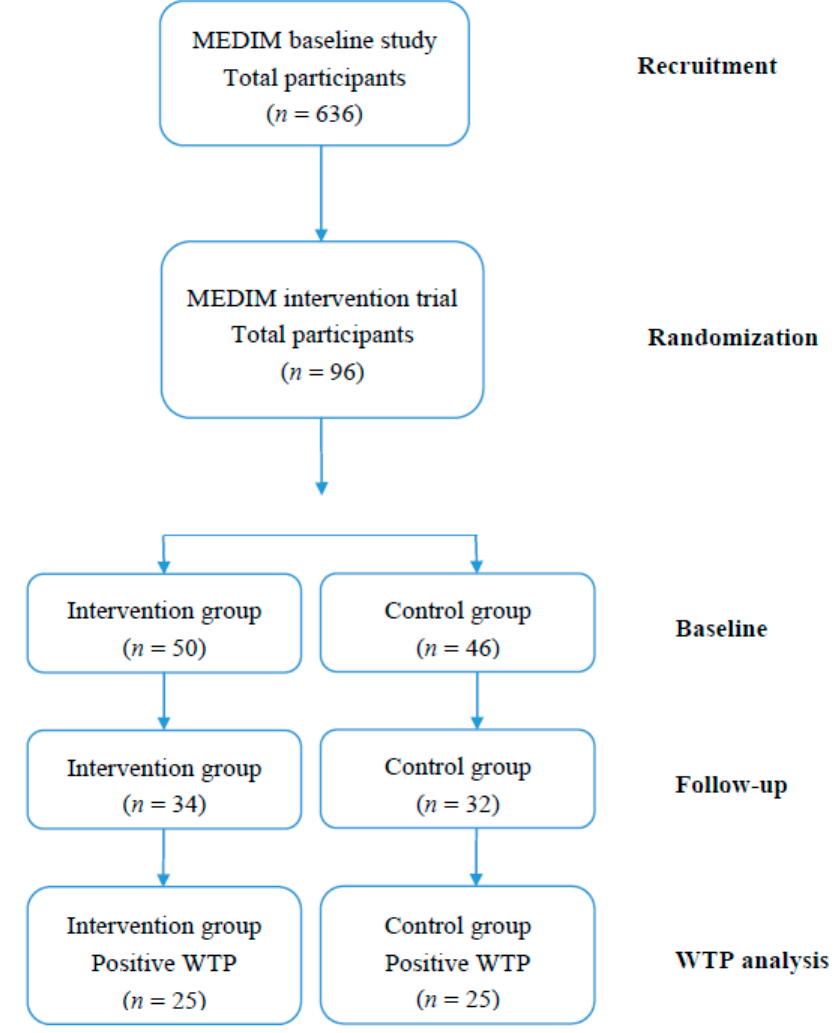
Figure 1. Flowchart of the MEDIM study participants.